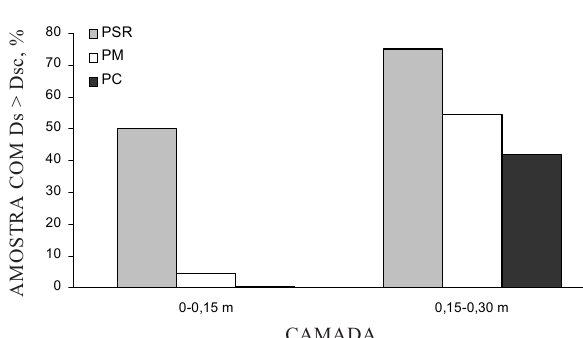
Figura 4. Percentagem de amostras com Ds acima da densidade do solo crítica (Dsc) nas duas camadas amostradas, para cada sistema de pre- paro do solo. PSR = preparo sem revolvimento; PM = preparo mínimo; PC = preparo con-